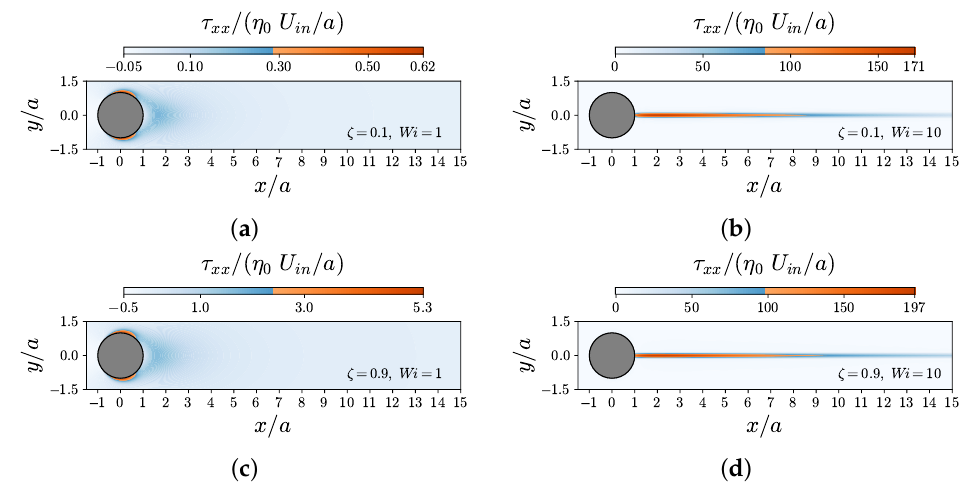
Figure 4. Contours of the viscoelastic drag coefficient correction, χ , for the Oldroyd-B fluid at 0 < Re ≤ 50, 0 ≤ Wi ≤ 10 and ( a ) ζ = 0.05 and ( b ) ζ = 0.9. Panels ( c , d ) show the variation of χ with Weissenberg numbers for different values of ζ at Re = 50.